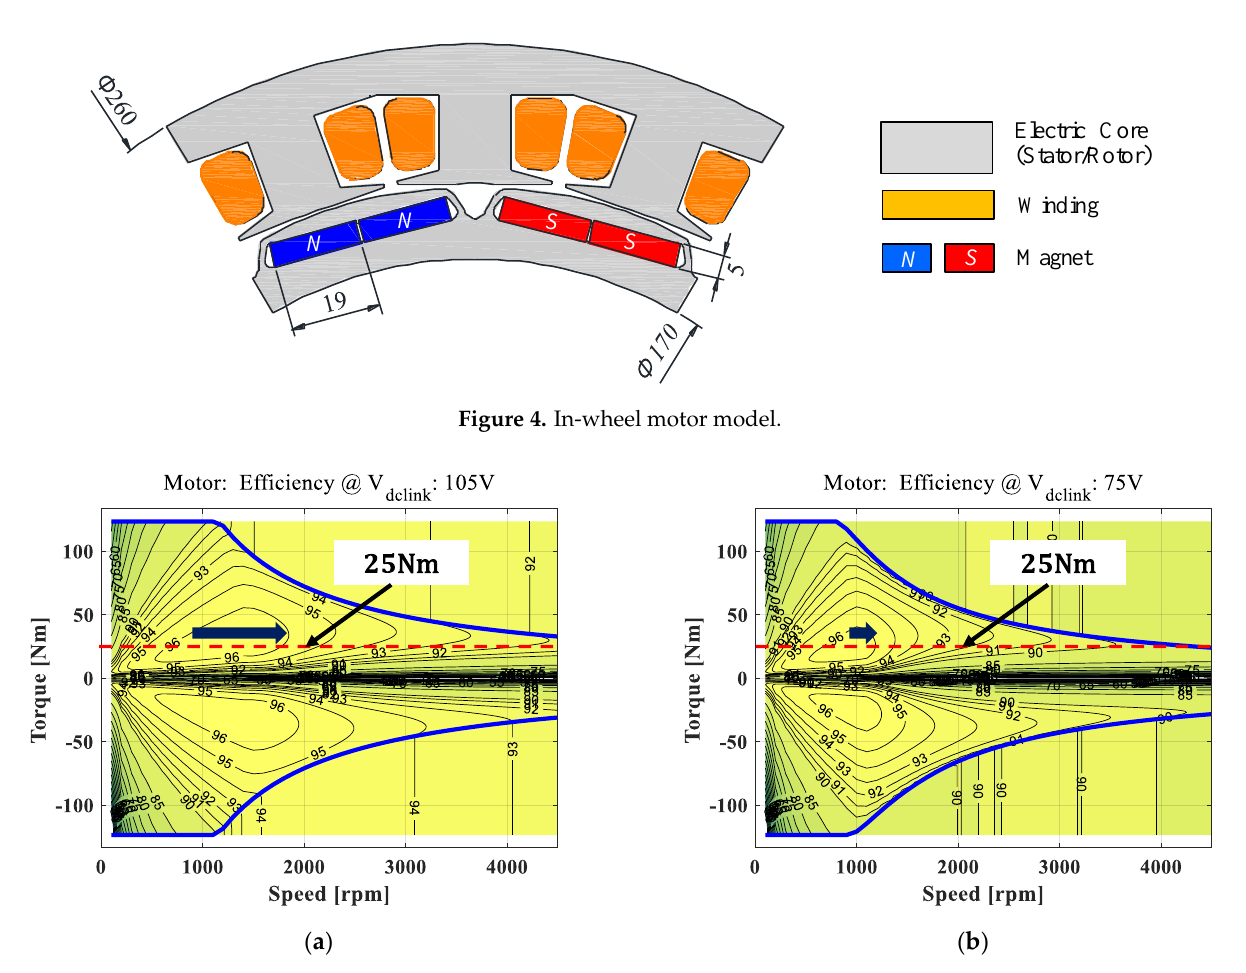
Figure 5. Efficiency map according to V dclink : ( a ) V dclink = 105 V and ( b ) V dclink = 75 V. Based on the FEM results, the information needed for the efficiency map of the motor is derived through the following Equation of torque (10) and Equations of voltage (11)– (13) [13], by using the equivalent circuit (Figure 6) on the dq -axis of the motor [14]: